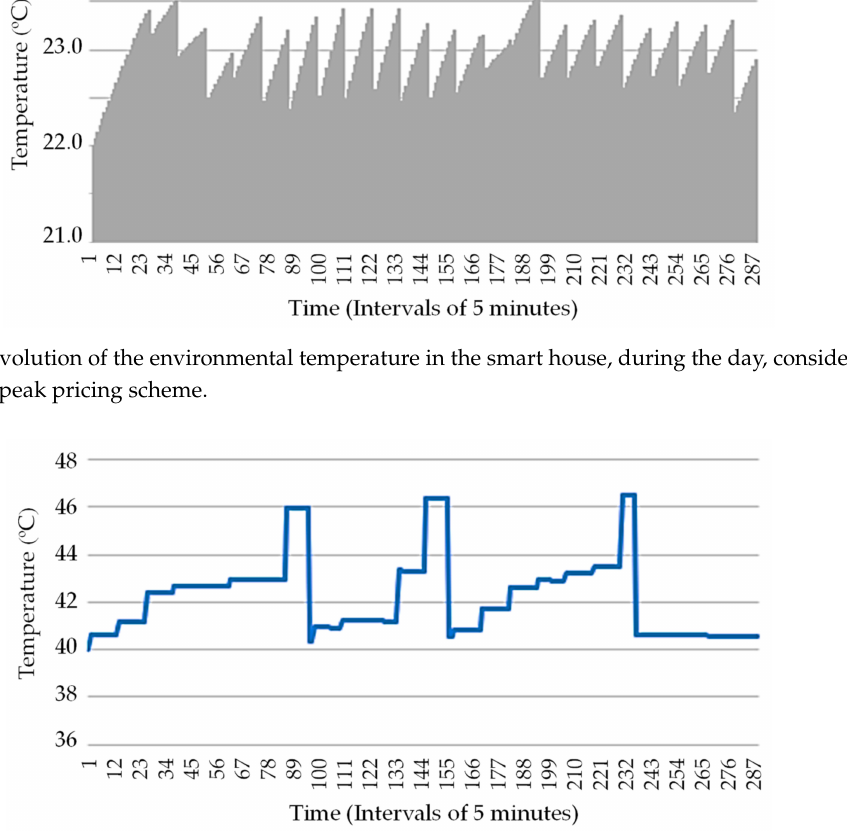
Figure 10. Evolution of the temperature in the sanitarian water heater tank, during the day, considering the flat pricing scheme.